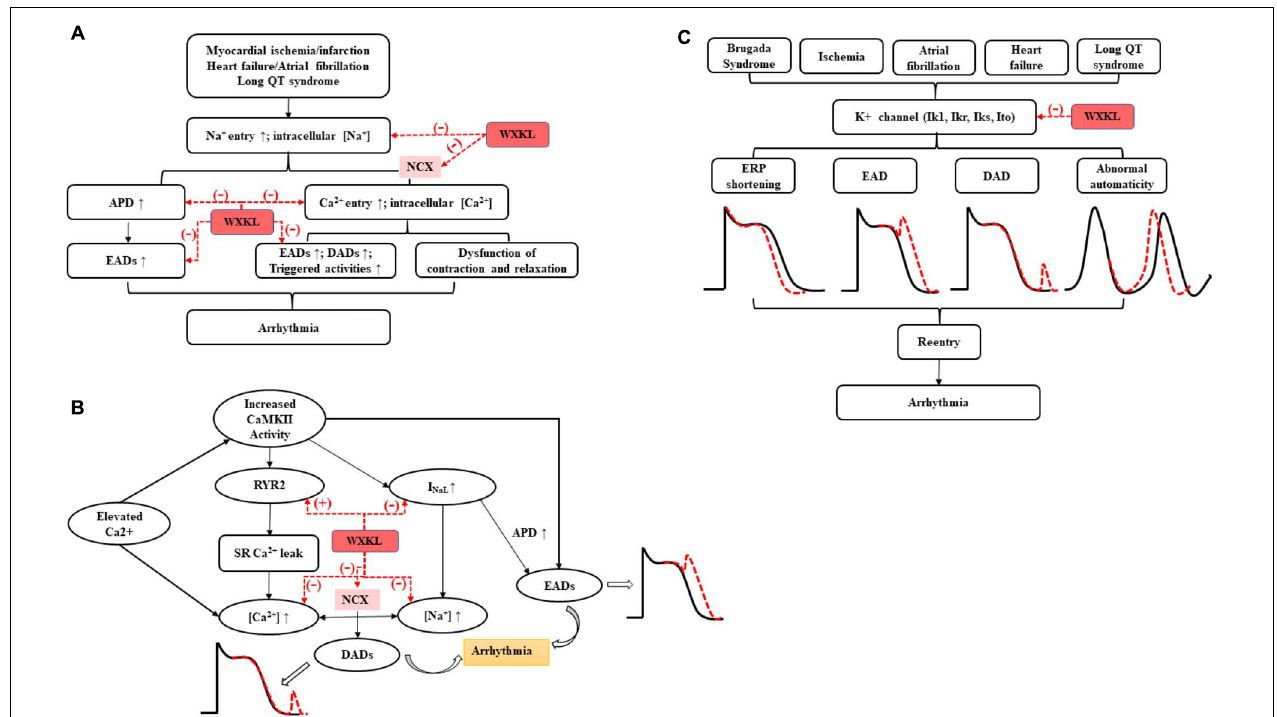
FIGURE 5 | The antiarrhythmic effects of WXKL on (A) sodium channels, (B) calcium channels, and (C) potassium